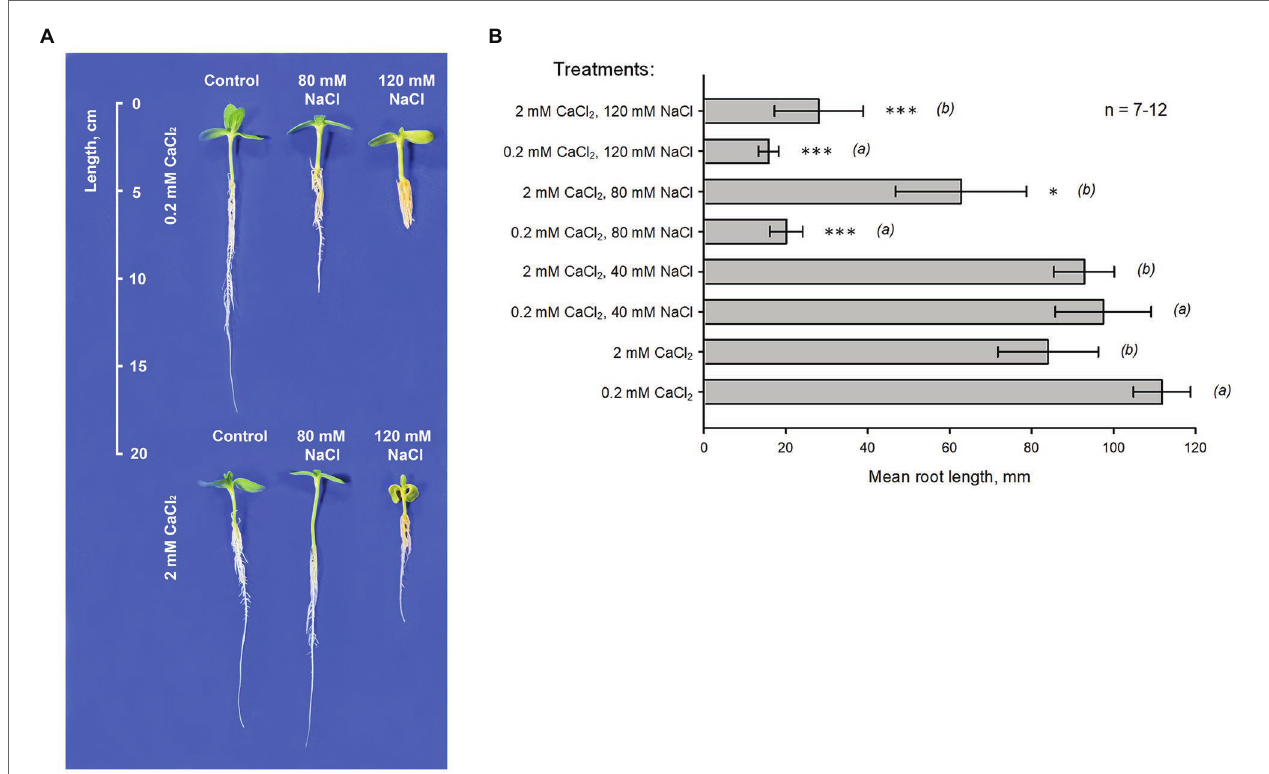
FIGURE 1 | Effect of external Ca 2+ on the inhibition of H. annuus L. root growth induced by NaCl. (A) Typical sunflower seedlings cultivated in hydroponics during 7 days (after 2-day germination) on the background of 0.2 or 2 mM CaCl 2 (upper and lower panels, respectively). “Control”: plants grown in control conditions (5% MS; pH 6.0). “80 mM NaCl” and “120 mM NaCl”: plants grown in the presence of 80 or 120 mM NaCl, respectively. (B) Mean ± SE ( n = 7–12) root length values measured in different conditions (as indicated in the figure). ( a ) and ( b ) are groups for comparison (ANOVA test); * p < 0.01; *** p <